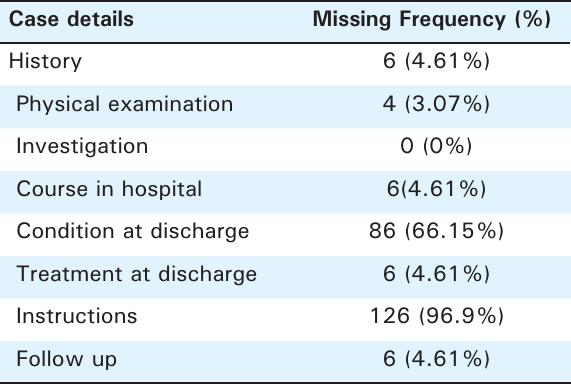
Table 5. Case details and missing frequency Case details